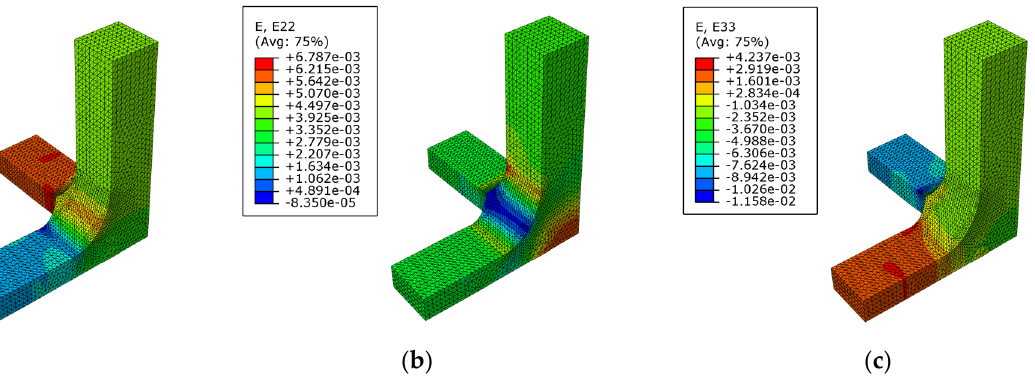
Figure 18. In geometry A for the CTC loading case and the scenario II: ( a ) Strain field in the x-direction; ( b ) strain field in the y-direction; ( c ) strain field in the z-direction. The estimation of the strain tensor from the direct measurements averaged along the length of each path is shown in Equation (8). As well, the hydrostatic and the deviatoric parts of the strain tensor are given in Equations (9) and (10), respectively.